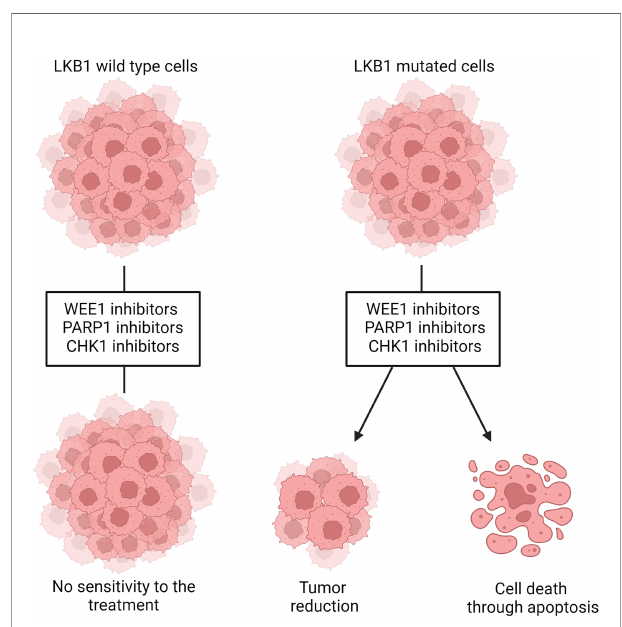
FIGURE 4 | Representation of WEE1, PARP1 and CHK1 inhibition in LKB1 wildtype and mutated cells. LKB1 wildtype cells are not sensitive to the treatment with those inhibitors while, in LKB1 -mutated cells, they leads to decreased cell viability and tumor size and/or increased DNA damages that, in turn, induce cells death through apoptosis. Created with